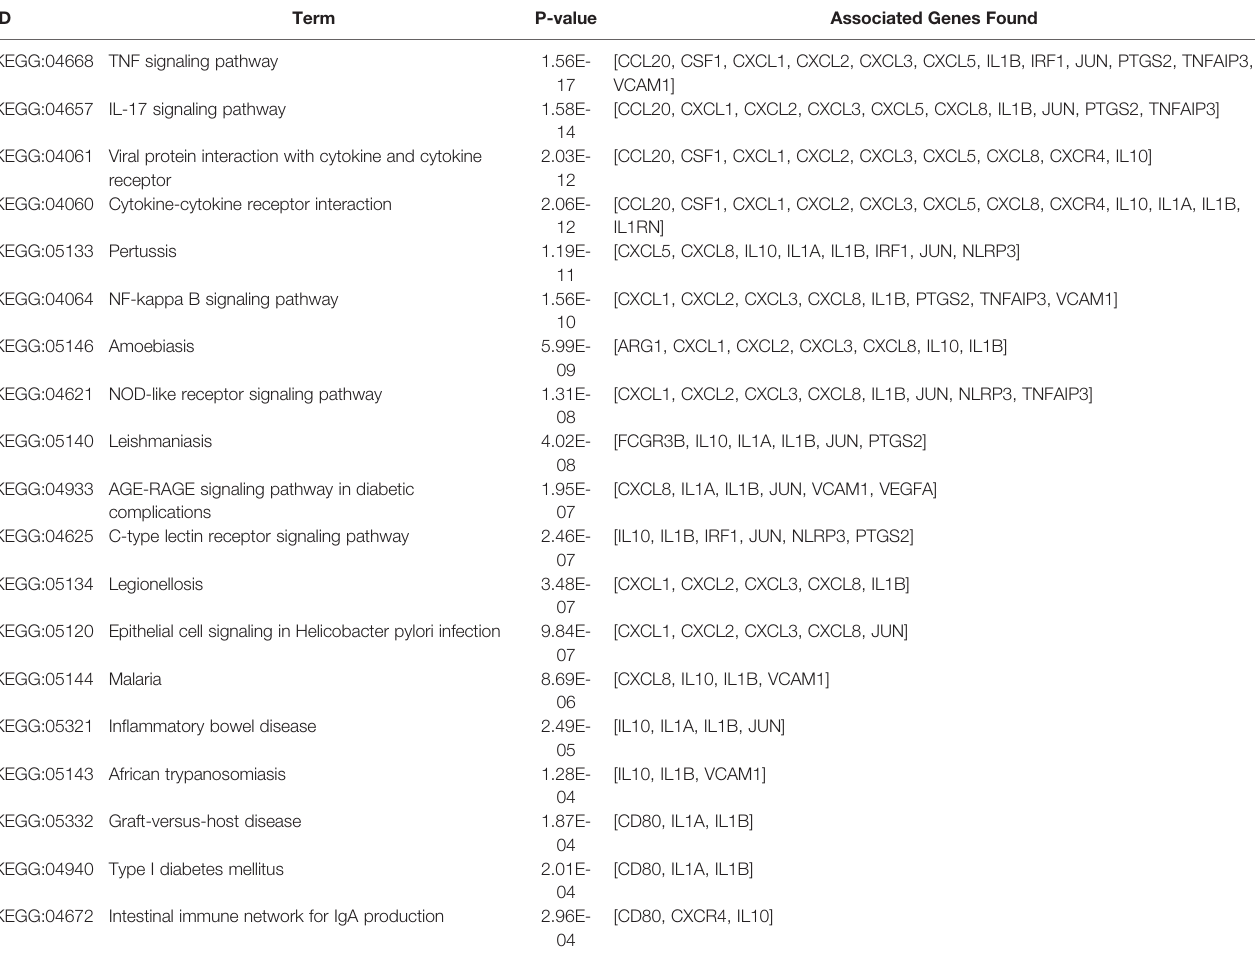
TABLE 3 | KEGG pathway of the 23 characteristic up-regulated genes. ID